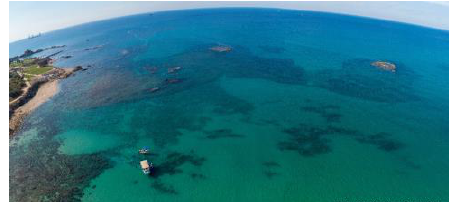
Figure 2: Location of the shipwreck. Top: the geolocation. Bottom: an aerial view of the excavation north to the Herodian